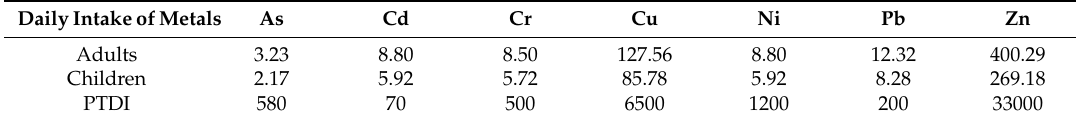
Table 2. Dietary intake of trace metals ( µ g · day − 1 ) for adults and